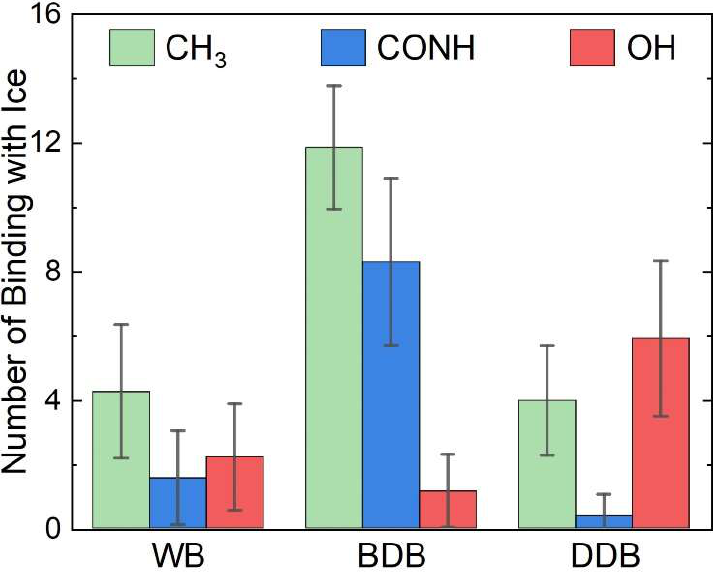
Figure 4. The –CH 3 , –CONH– and –OH groups play a crucial role in the binding of AFGP8 to ice. The average number of methyl groups (green rectangles) interact with ice and the average hydrogen bonds of amide groups (blue rectangles) or hydroxyl groups (red rectangles) interact with ice, in the cases of weak binding (WB), backbone dominant binding (BDB) and disaccharide dominant binding (DDB), respectively.